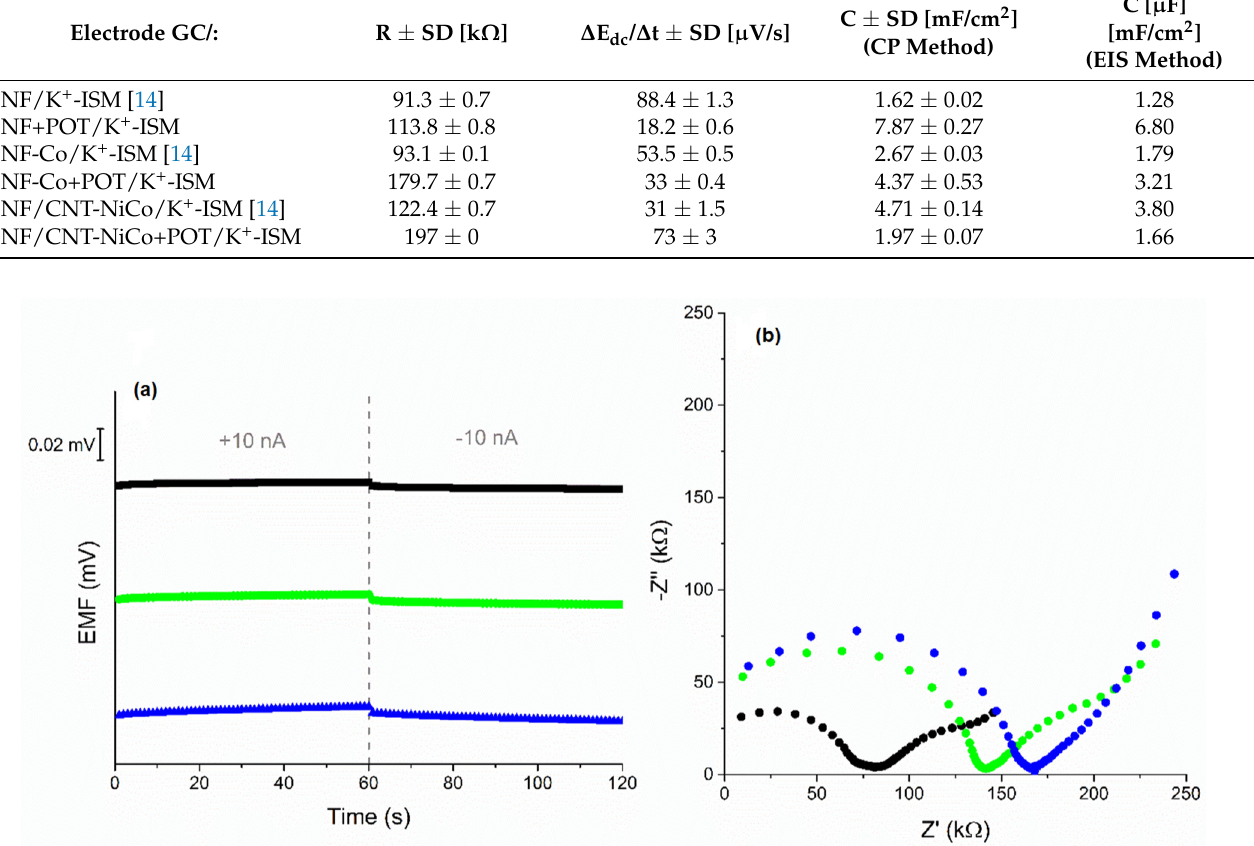
Figure 3. Chronopotentiograms of investigated electrodes ( a ) and Nyquist plots ( b ) of GC/eCNF + POT/K + -ISM (black), GC/eCNF-Co+POT/K + -ISM (green), GC/eCNF/CNT-NiCo + POT/K + -ISM (blue), recorded in 0.01 M KCl. NiCo+POT/K + -ISM (blue), recorded in 0.01 M